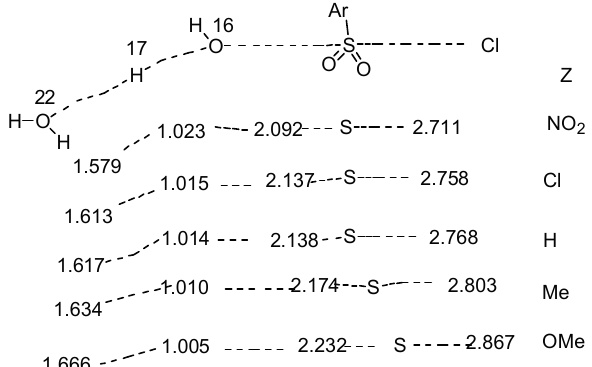
Figure 12. Calculated [7] changes in bond lengths (Angstroms) in transition states for